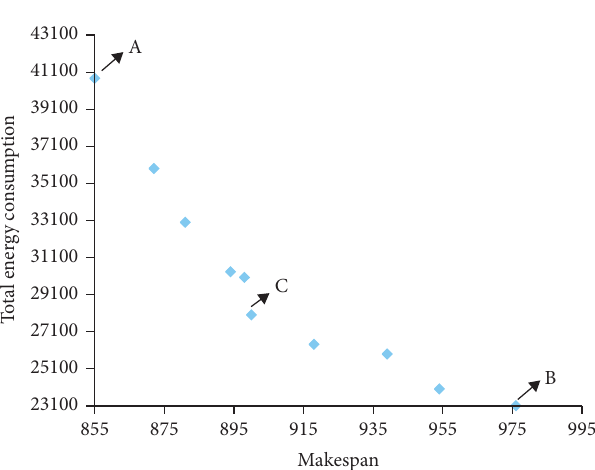
Figure 8: The noninferior solution set of the problem scale of